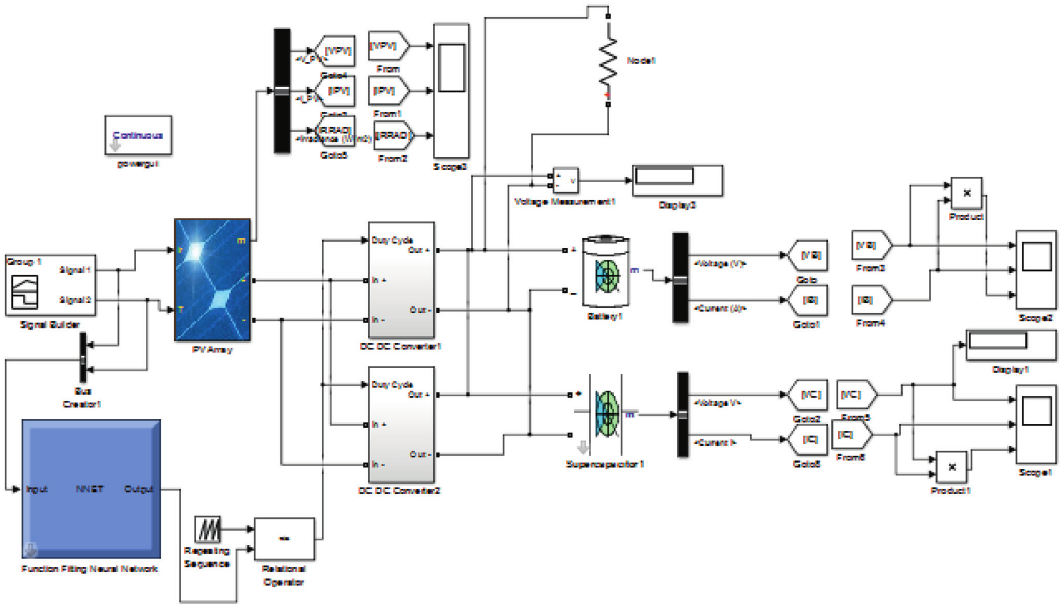
Figure 46: Proposed overall circuit.